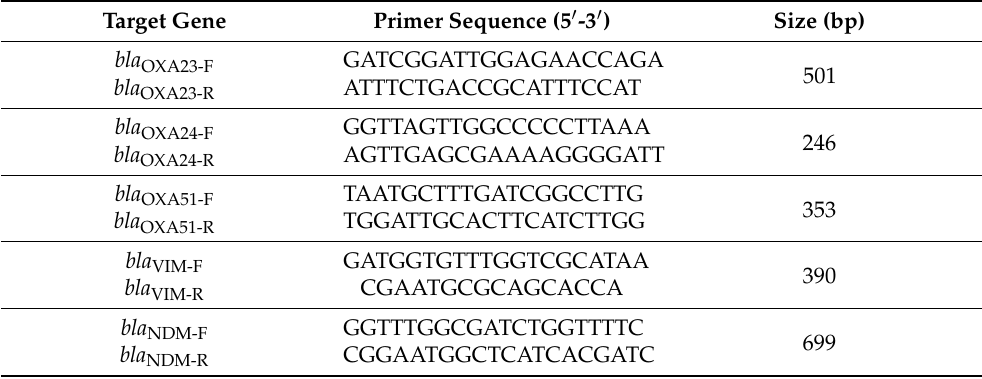
Table 3. The list of primers used in the study. Target